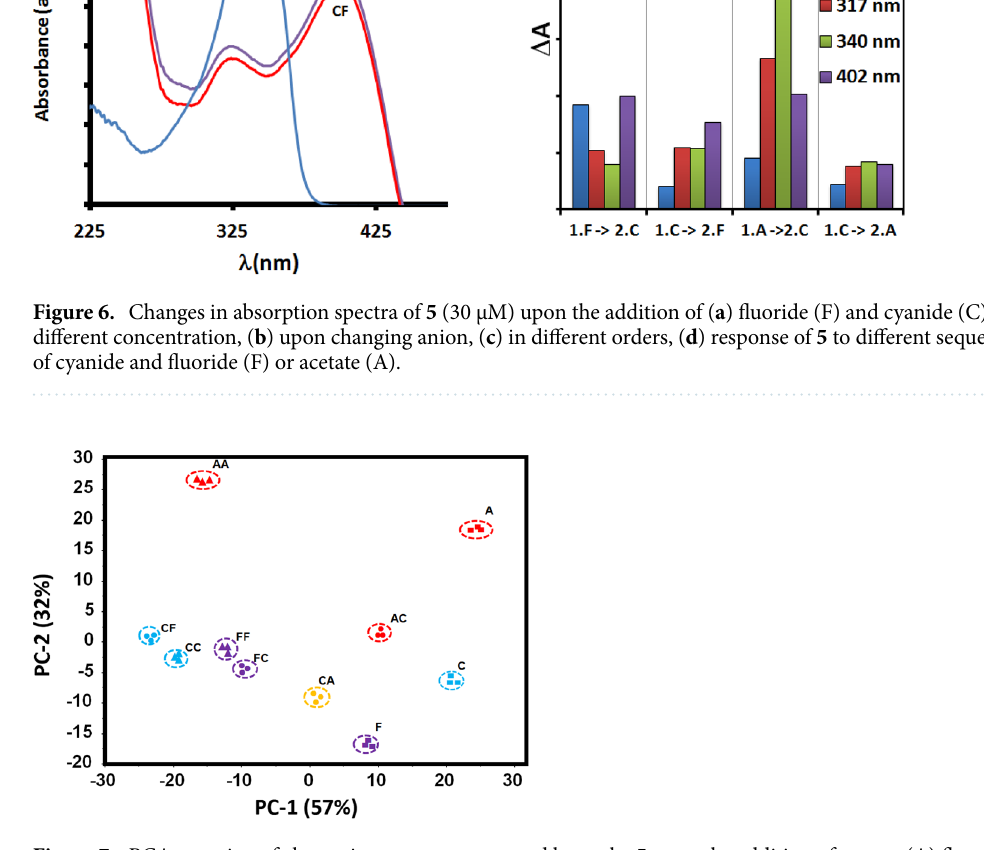
Figure 7. PCA mapping of absorption patterns generated by probe 5 upon the addition of acetate (A) fluoride (F) and cyanide (C) in three replicates of different sequences and